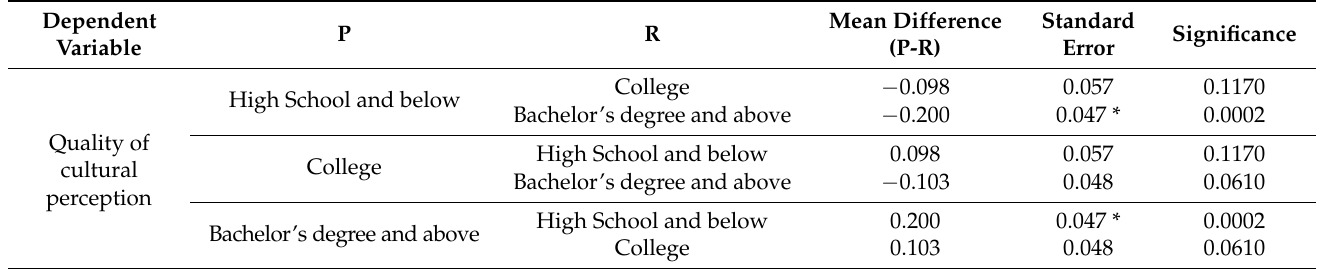
Table 5. One-way ANOVA test for the effect of educational background on the perceived quality of culture ( n =